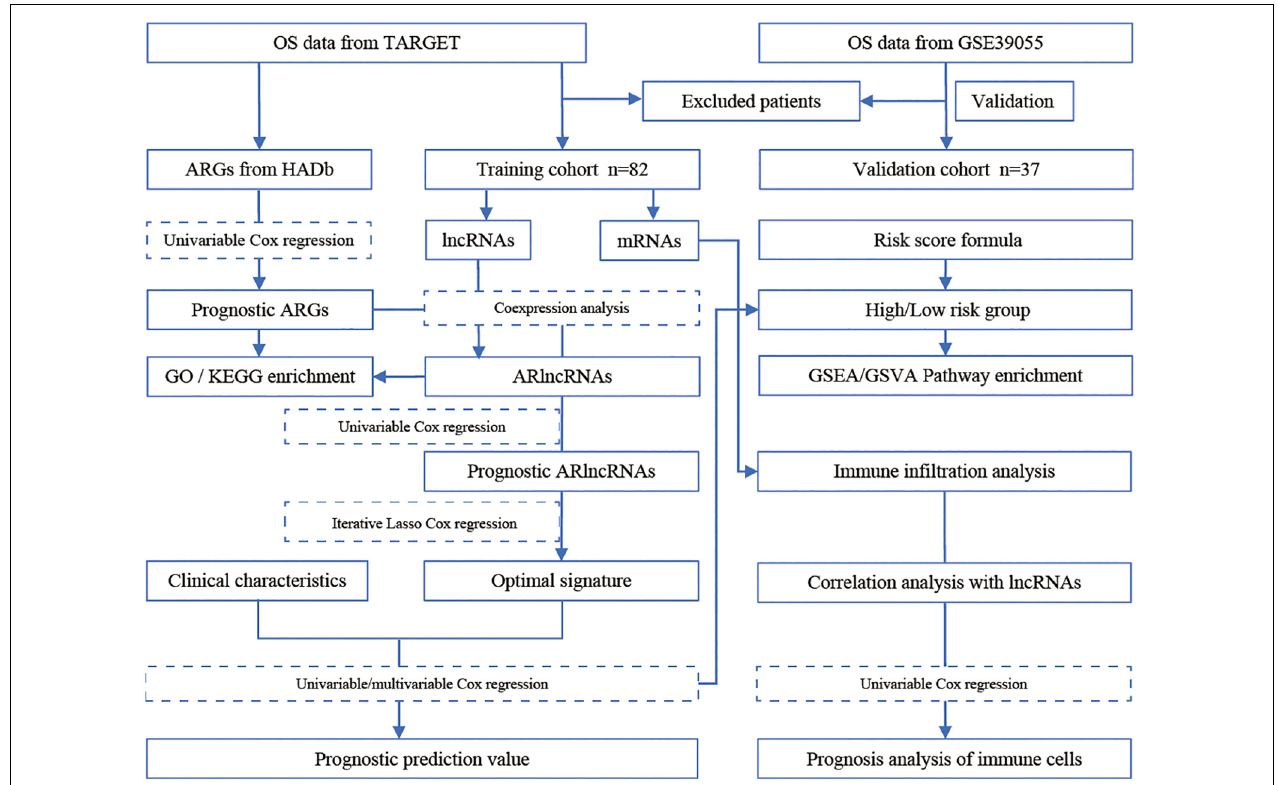
FIGURE 1 | Study flowchart of the identification of a prognostic lncRNA signature in